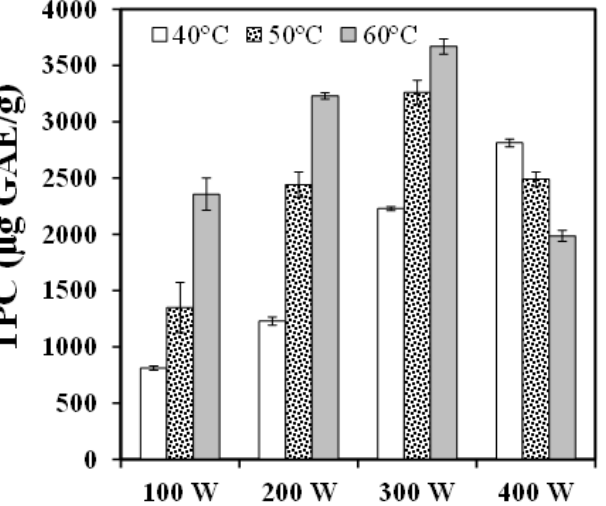
Figure 3. Thermosonication effects on the total phenolic content (TPC) of fennel extracts.